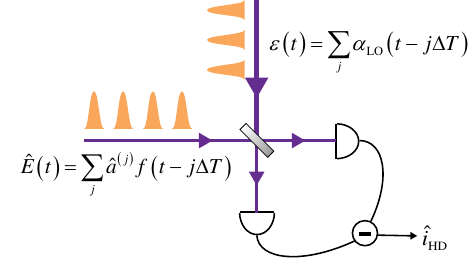
FIG. 2. Schematics for homodyne detection with a train of